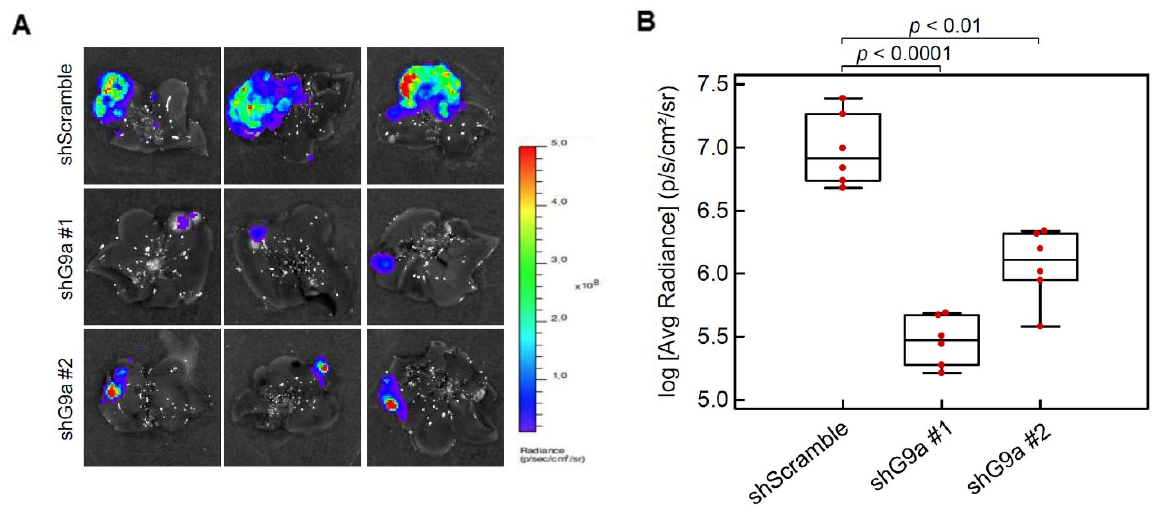
Figure 3. G9a promotes hepatocellular carcinoma (HCC) growth in an orthotopic mouse model. Luciferase-tagged Mahlavu cells with stable expression of control or G9a shRNA were orthotopically injected into the liver of 8-week-old NOD/SCID mice, and animals were sacrificed 6 weeks after tumor implantation. ( A ) Cancer growth of Mahlavu xenografts was imaged with bioluminescence at the end of the study. ( B ) Quantitative analysis of imaging signal intensity (photons/s/cm 2 /sr), with the mean signal for each group indicated.